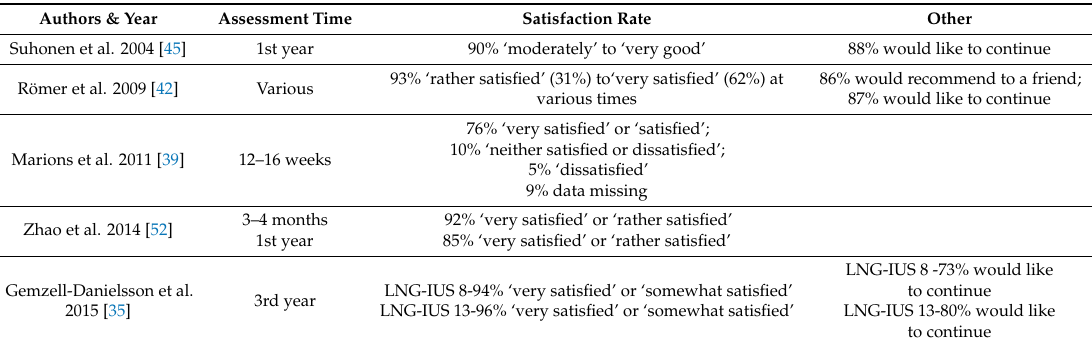
Table 4. Satisfaction